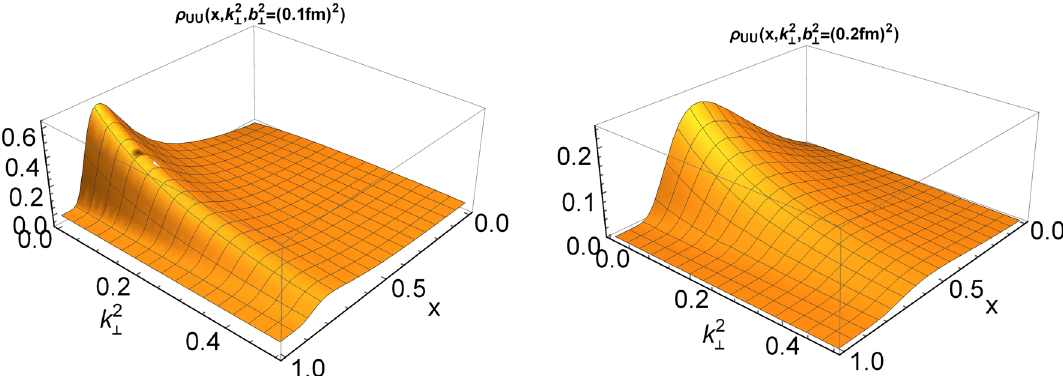
Fig. 13 The unpolarized Wigner distribution ρ UU at | b ⊥ | = 0 . 1 fm, and | b ⊥ | = 0 . 2 fm. The δ 2 ( b ⊥ ) component – first line of Eq. (88) – is suppressed in the